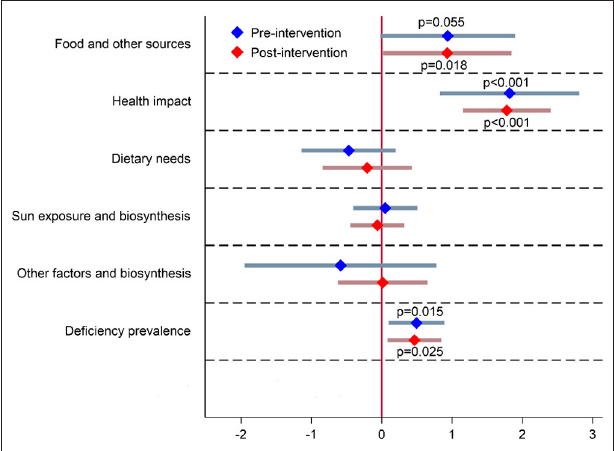
FIGURE 4 | Logistic regression analysis for distinct dimensions of vitamin D-related knowledge in pre-intervention (Model 1: April 2020) and post-intervention (Model 2: December 2020) prevalence of vitamin D supplementation. Area under receiver operating characteristic (ROC) curve: 0.66 (pre-intervention) and 0.67 (post